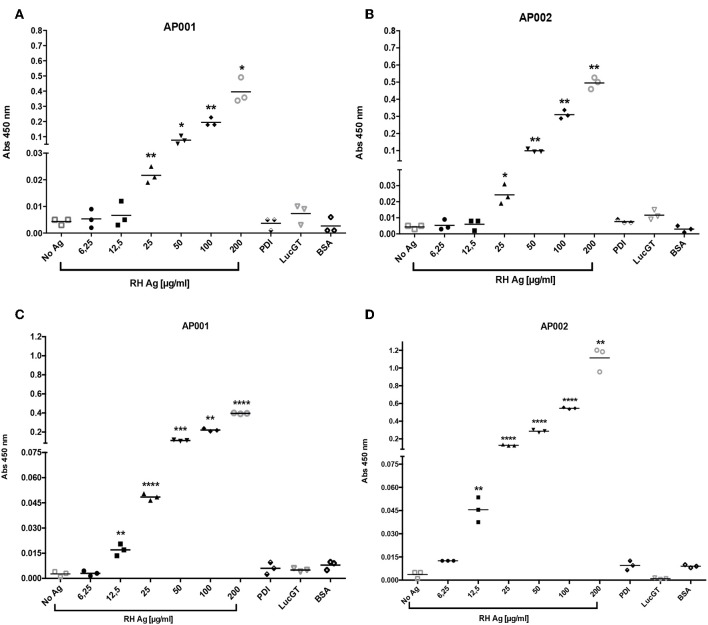
Detection limit of RH antigen according time and temperature. The ELAA assays were performed with AP001 (A,C) and AP002 (B,D) anti-ROP18 aptamers. We evaluated incubation 1 h at 37°C (A,B) and 4°C overnight (C,D). Different concentrations of T. gondii total antigen of the RH strain (RH Ag) were evaluated and three negative controls, PDI, LucGT, and BSA were included. The data are represented with the mean of each sample evaluated in triplicate. Welch's t-test. *p < 0.05, **p < 0.01, ***p < 0.001, ****p < 0.0001 vs. controls without antigen (No Ag).